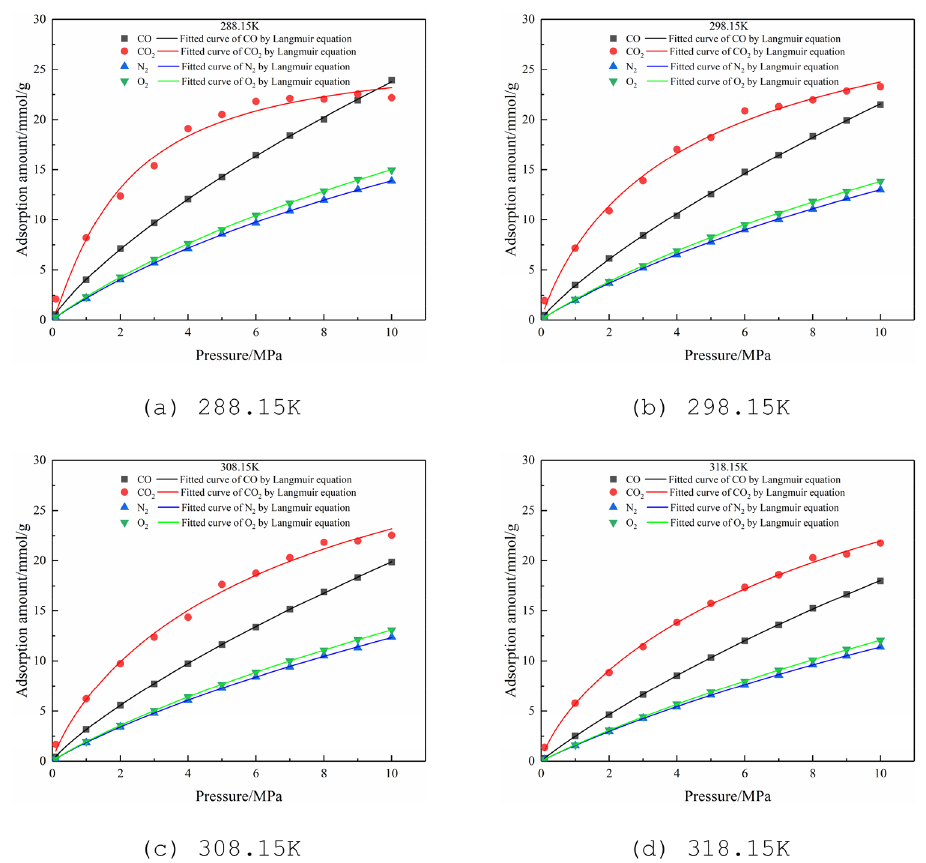
Figure 5. Adsorption isotherms of CO, CO 2 , N 2 , and O 2 at different